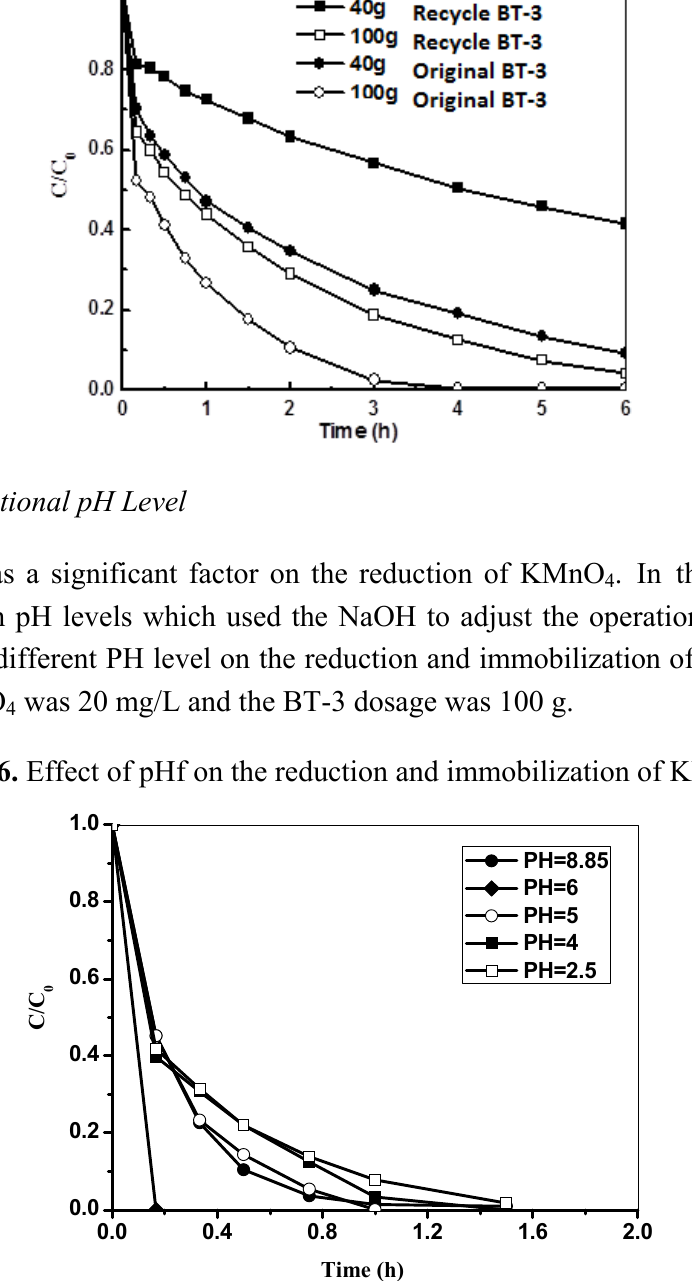
Figure 5. Effect of dosage of BT-3 on the immobilization of KMnO